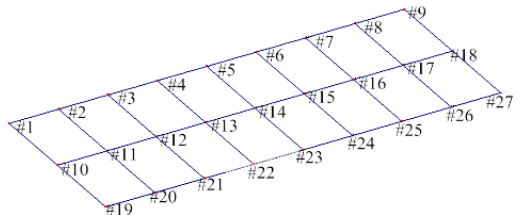
Figure 5. Layout of measuring points in modal measurement.